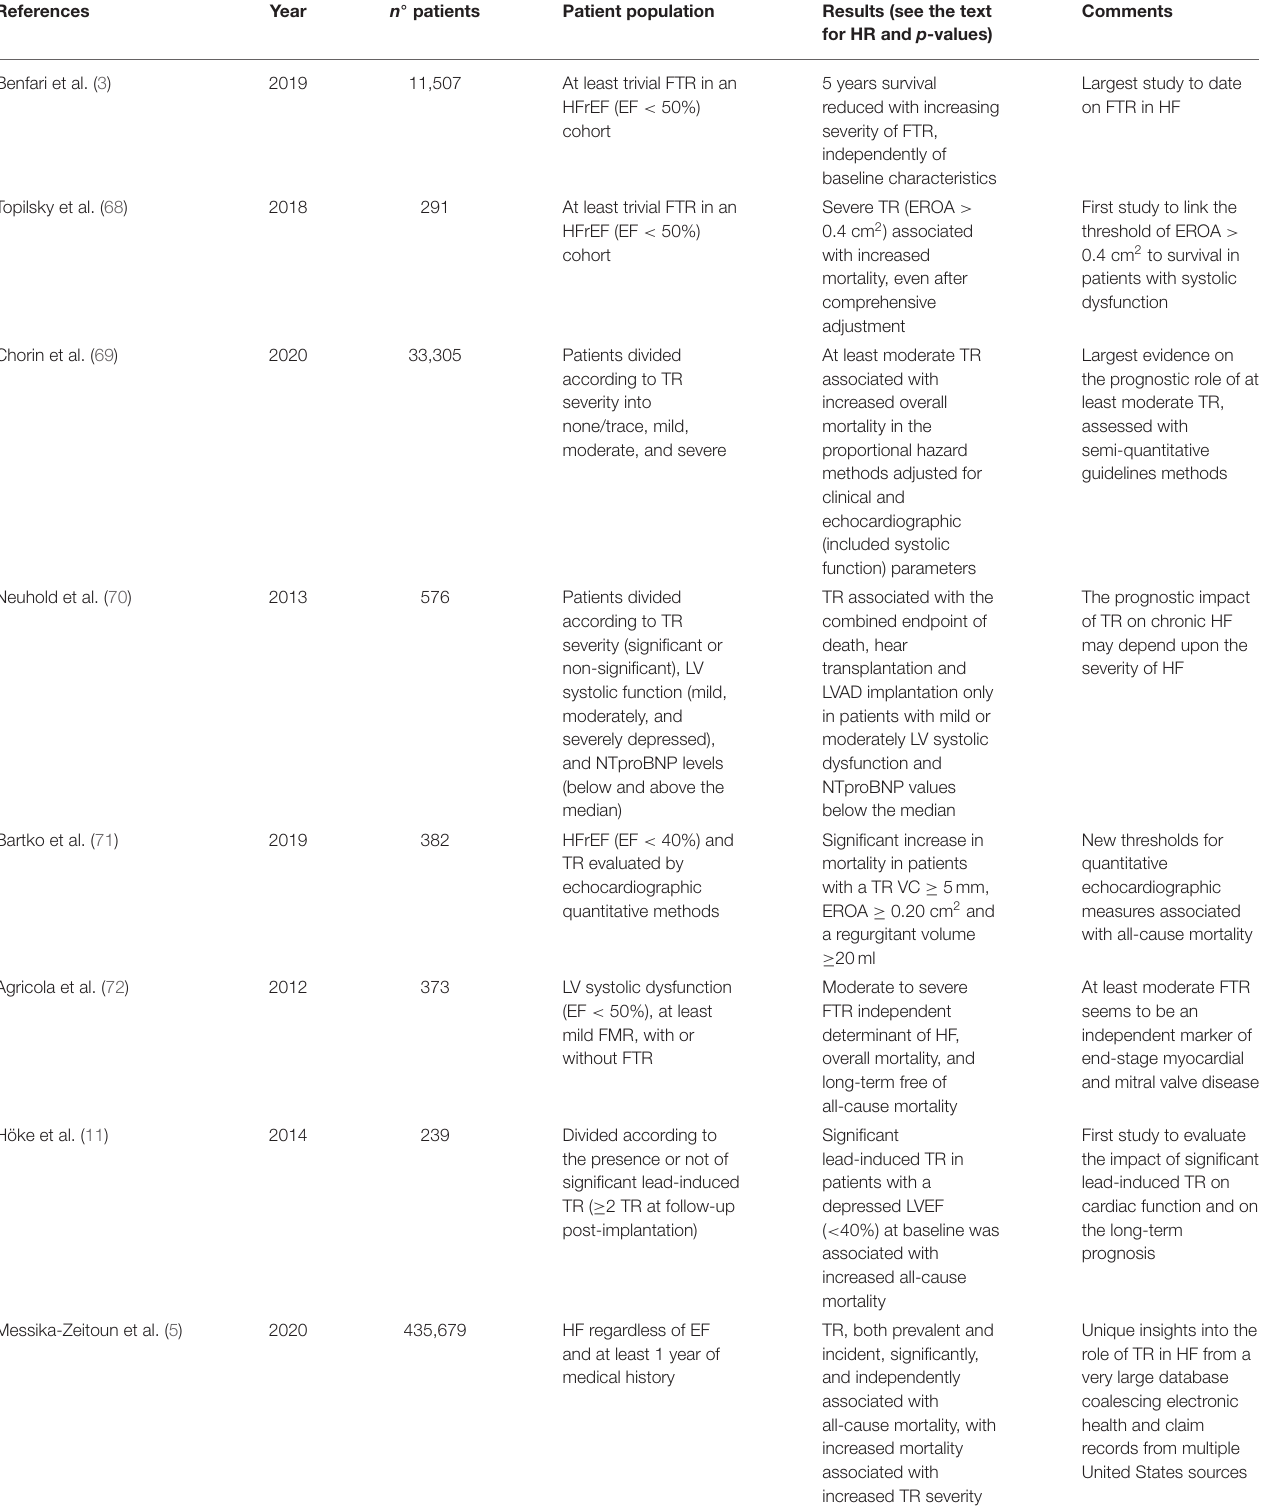
TABLE 1 | Summary of the main studies cited in the text on the prognostic role of TR with LV systolic dysfunction (specific references from the text are